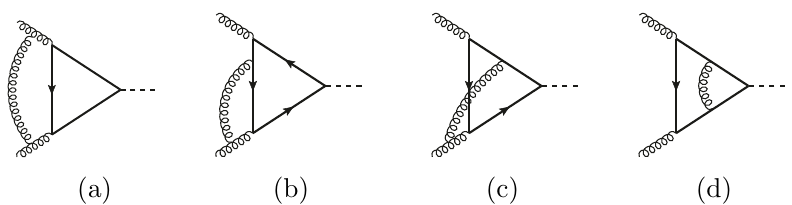
Figure 5 . The two-loop Feynman diagrams for the bottom quark mediated gg ! H fusion, which contribute in the double-logarithmic approximation. Symmetric diagrams and the diagrams with the opposite direction of the closed quark line are not